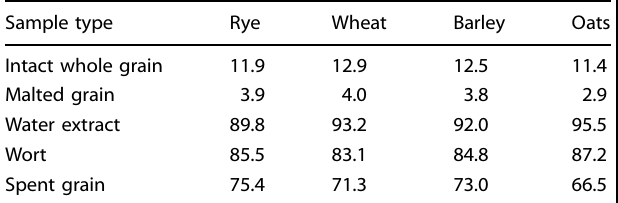
Table 2. Moisture content (% w/w, average) in the analyzed samples. The moisture content of the rootlets was not measured separately, but it can be assumed equivalent to that in malted grain because the rootlets were separated from the malted grains right after the drying